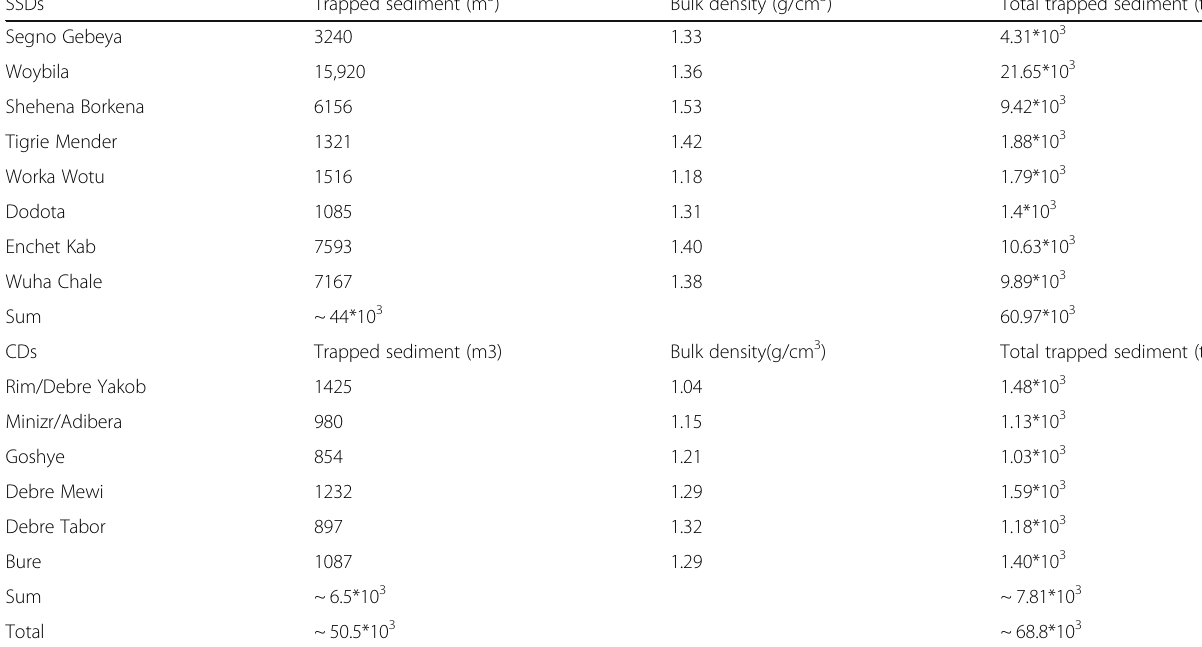
Table 2 Volume and mass of sediment trapped by SSDs and CDs SSDs Trapped sediment (m 3 ) Bulk density (g/cm 3